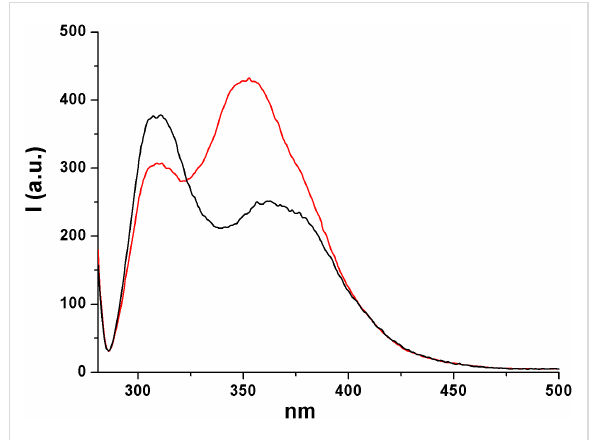
Figure 3: Emission spectrum of compound 3a in methanol (black) and in a methanol/TFE 4:1 mixture (red).